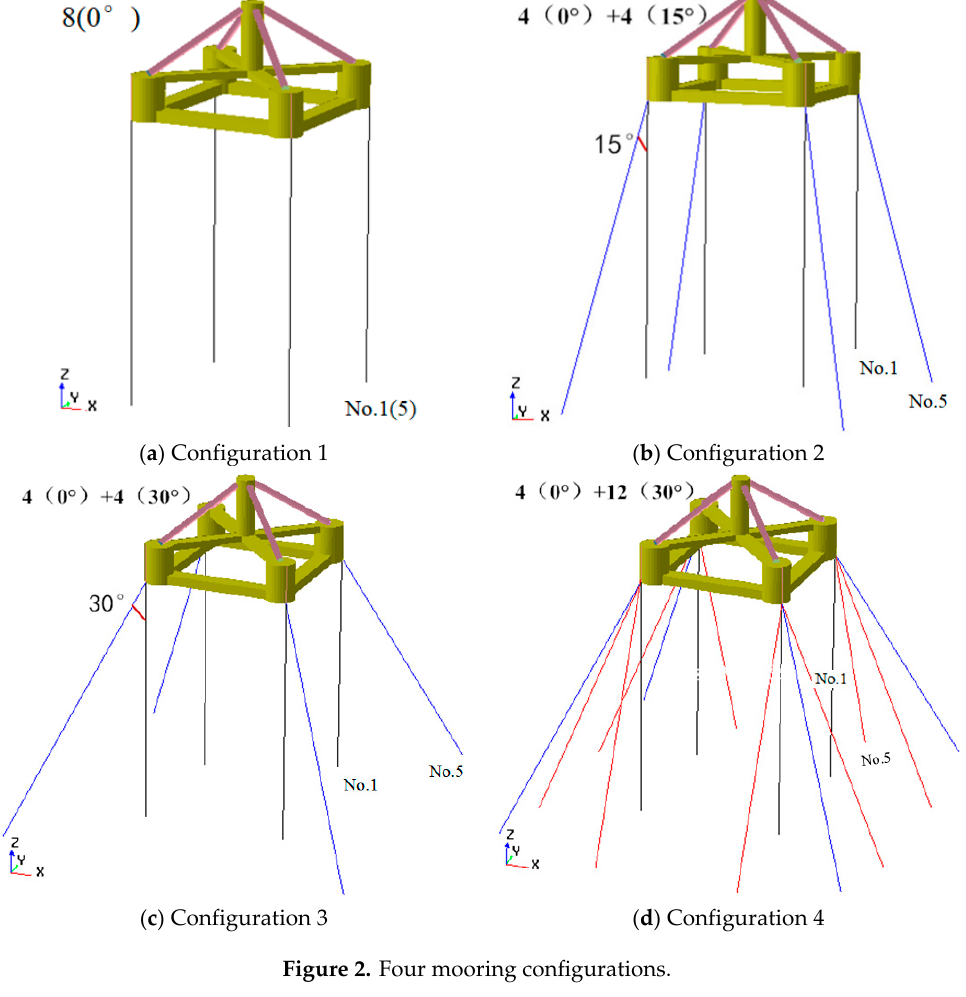
Figure 2. Four mooring configurations.